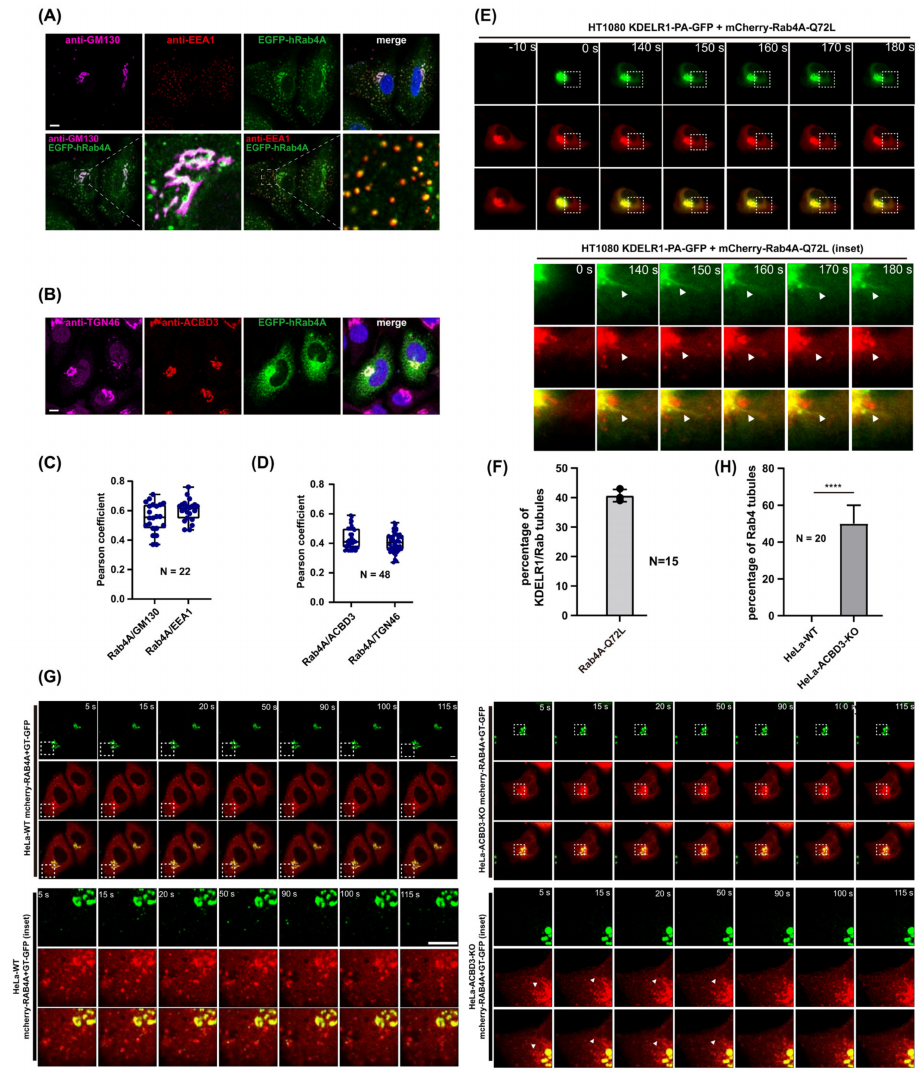
Figure 4. Overexpression of a constitutive active mutant Rab4A-Q72L promotes KDEL-R1 trafficking to the PM via Rab4A-positive tubular carriers at the Golgi. ( A – D ) To examine the Golgi